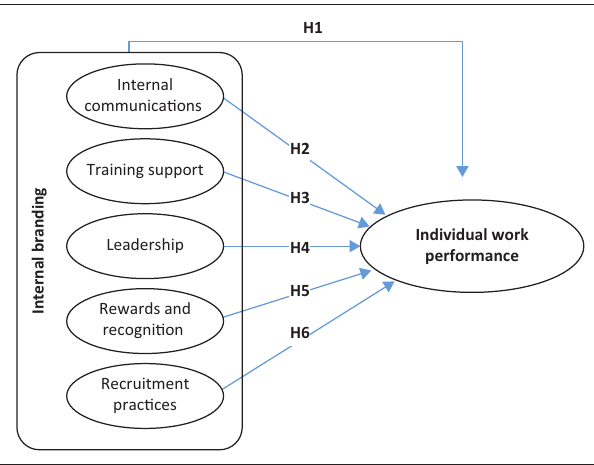
FIGURE 2: Graphic illustration of the conceptual framework.